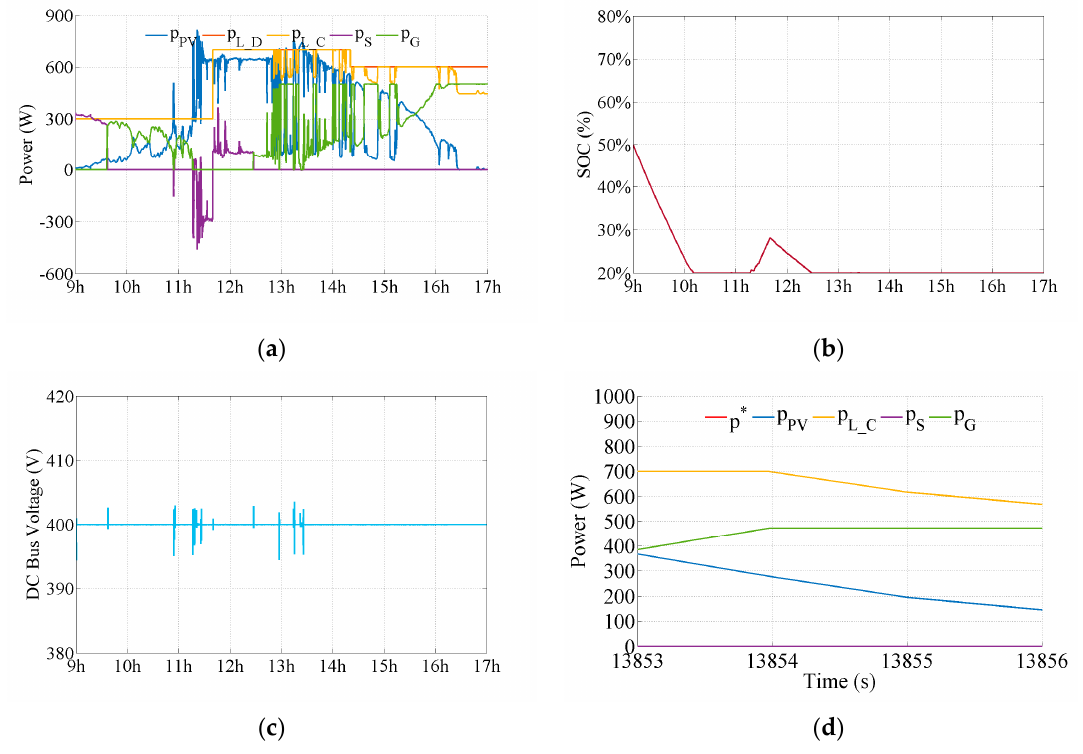
Figure 8. Power balancing with DCE and smaller PSM: ( a ) evolution of each microgrid power; ( b ) SOC evolution; ( c ) bus voltage evolution; ( d ) zoomed view of power at the time when microgrid failed in first test.